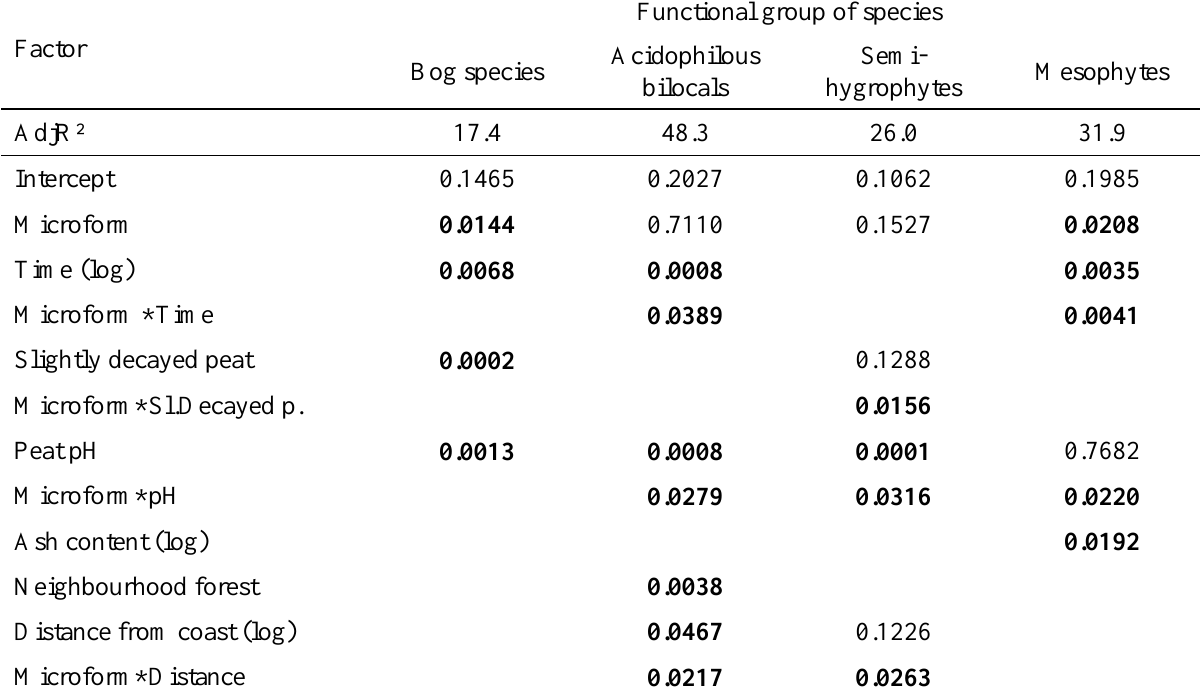
Table 2. GLM analysis showing significance levels (p-values) of environmental conditions affecting the species richness of functional groups. For descriptions of functional groups, see legend to Figure 2. Model effects are illustrated in Figure 2. Significant p-values are shown in bold